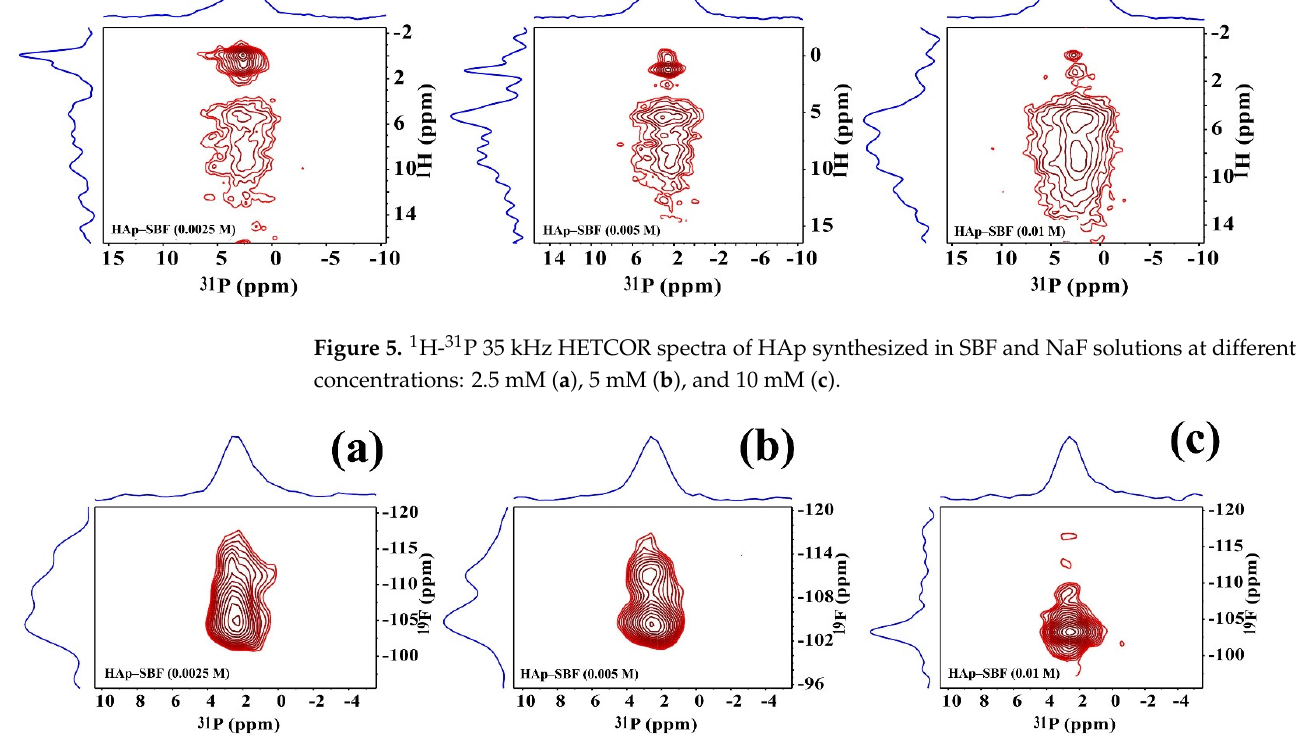
Figure 6. 19 F-31P 35 kHz HETCOR spectra of HAp synthesized in SBF and NaF solutions at different concentrations: 2.5 mM ( a ), 5 mM ( b ), and 10 mM ( c ). The gradual decrease of the cross peaks between ~108 to ~114 ppm corresponds to a decrease in the amorphous shell region and an increase of crystallinity.